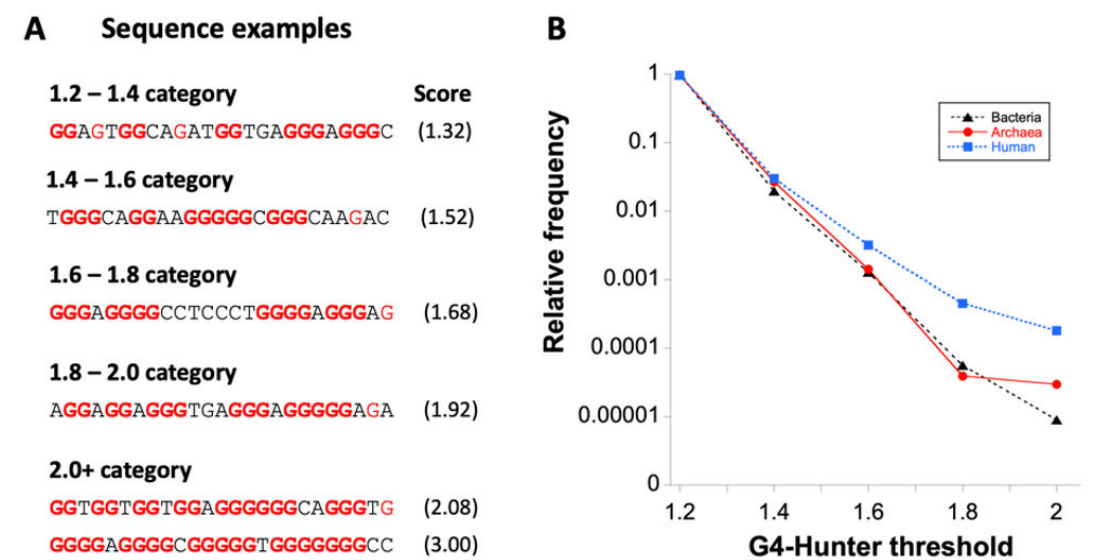
Figure 3. Examples of sequences with di ff erent G-quadruplexes (G4) Hunter scores (G4HS) and distribution of PQS according to threshold category. ( A ) Examples of archaea 25-nt long sequences (corresponding to the window size chosen for the analysis) for which G4Hunter scores are provided within parentheses. Isolated guanines are shown in red, all other guanines in bold red characters. Longer archaea motifs with high G4H scores are provided in Table 3. ( B ) Distribution of G4-prone motifs according to the G4Hunter score. 1.2 means any sequence with a score between 1.2 and 1.399; 1.4 between 1.4 and 1.599, etc. These numbers are normalized by the total number of PQS found in bacteria, archaea, and compared with Homo sapiens . The first category represents 97.9% and 97.2% of all PQS sequences in bacteria and archaea, respectively. Note the log scale on the Y-axis. Table 3. Genomic sequences sizes, GC%, total count of PQS, and mean frequencies of quadruplex motifs. Seq (total number of sequences), Median (median length of sequences), Short. (shortest sequence), Long. (longest sequence), GC % (average GC content), PQS (total number of predicted PQS), Mean f (mean frequency of predicted PQS per 1000 bp), Min f (lowest frequency of predicted PQS per 1000 bp), Max f (highest frequency of predicted PQS per 1000 bp). %PQS corresponds to the probability that any given nucleotide in the group or subgroup belongs to a G4-prone region (G4H > 1.2). Colors correspond to phylogenetic tree depiction.